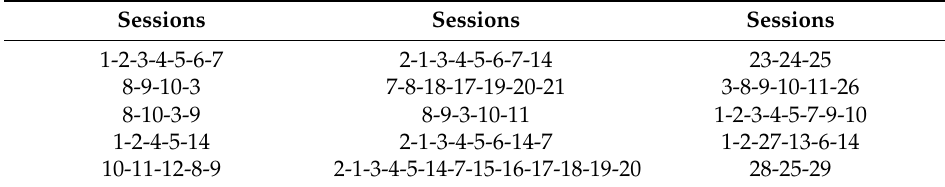
Table 6. A part of the extracted intrusion sessions of an infiltration attack.